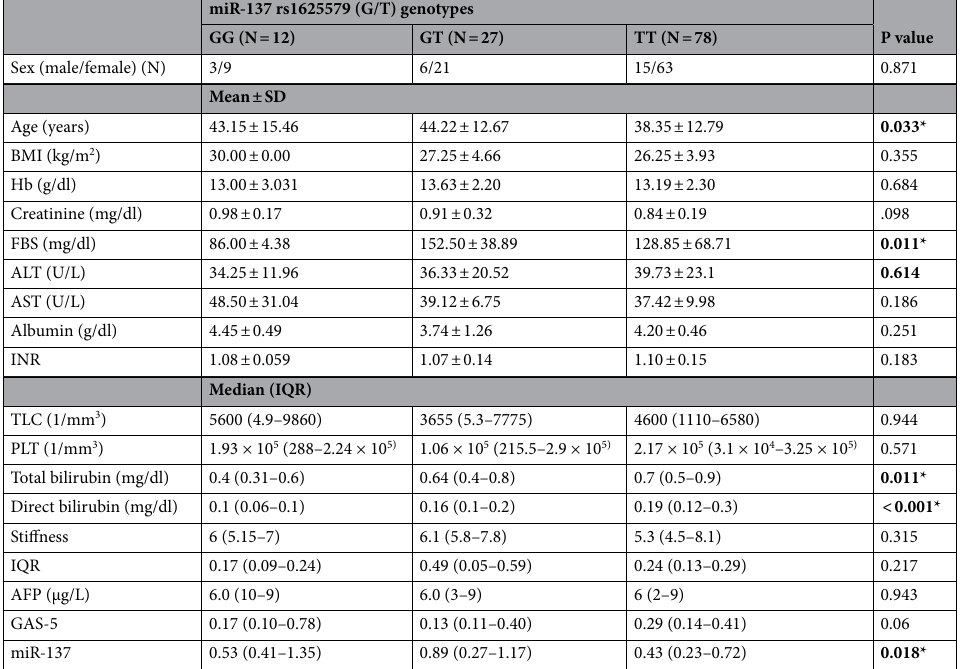
Table 4. Effect of miR-137 rs1625579 (G/T) on demographic, clinical and laboratory variables of chronic viral hepatitis B patients. BMI body mass index, GAS-5 lncRNA growth arrest-specific 5, miR-137 microRNA